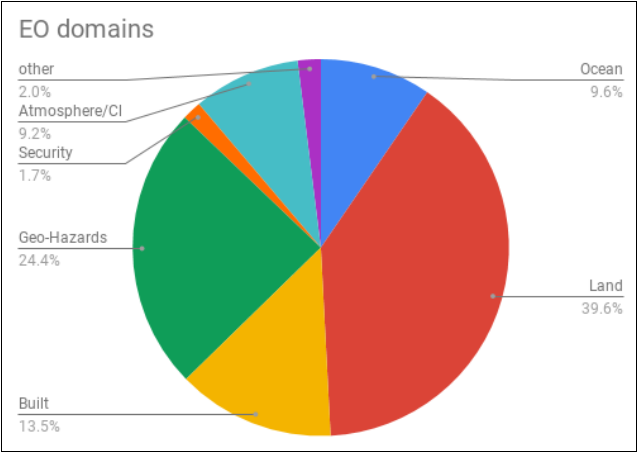
Figure 18. EO domains represented by the total participation in the requirements